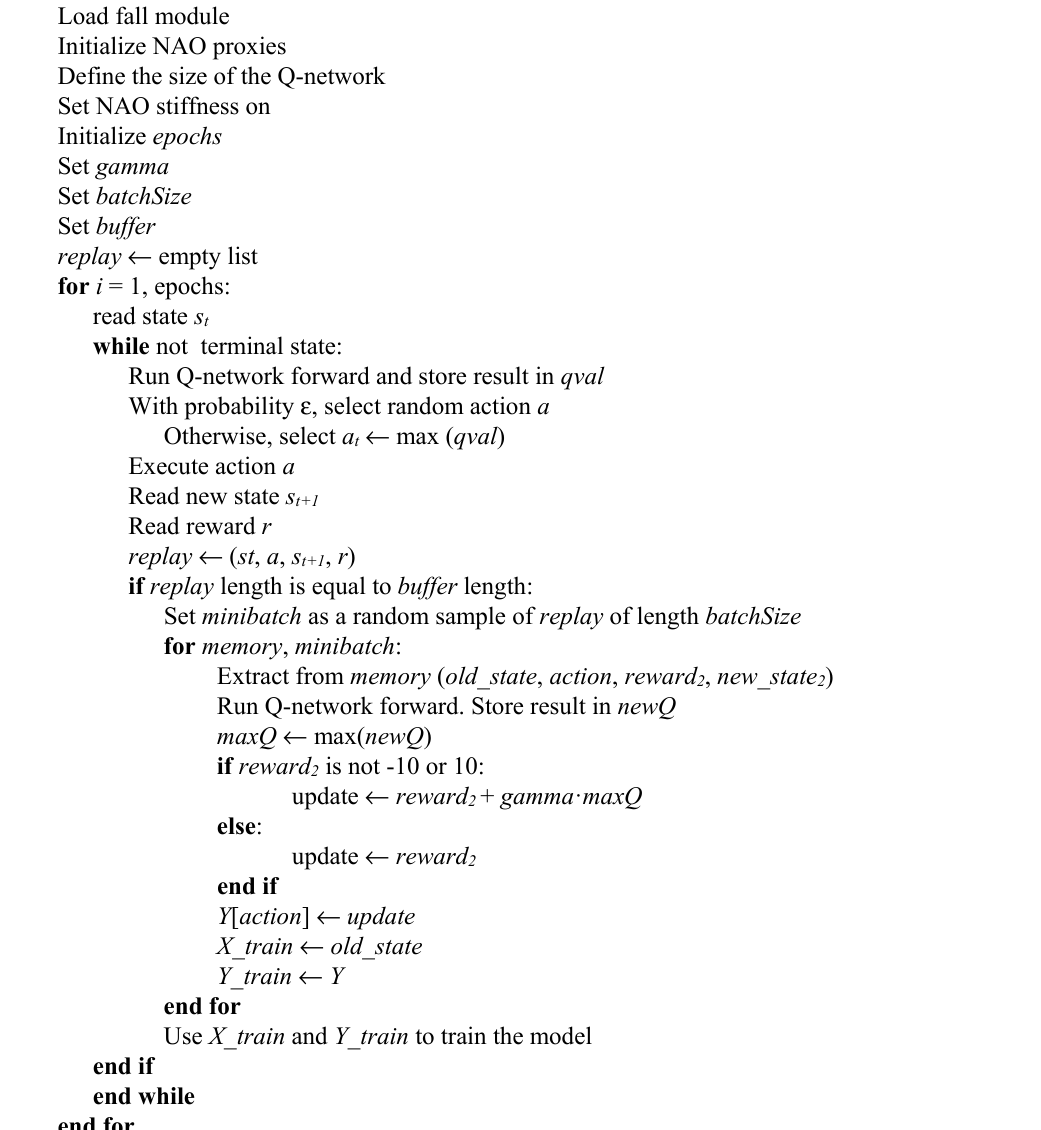
Figure 15. Q-network Algorithm.